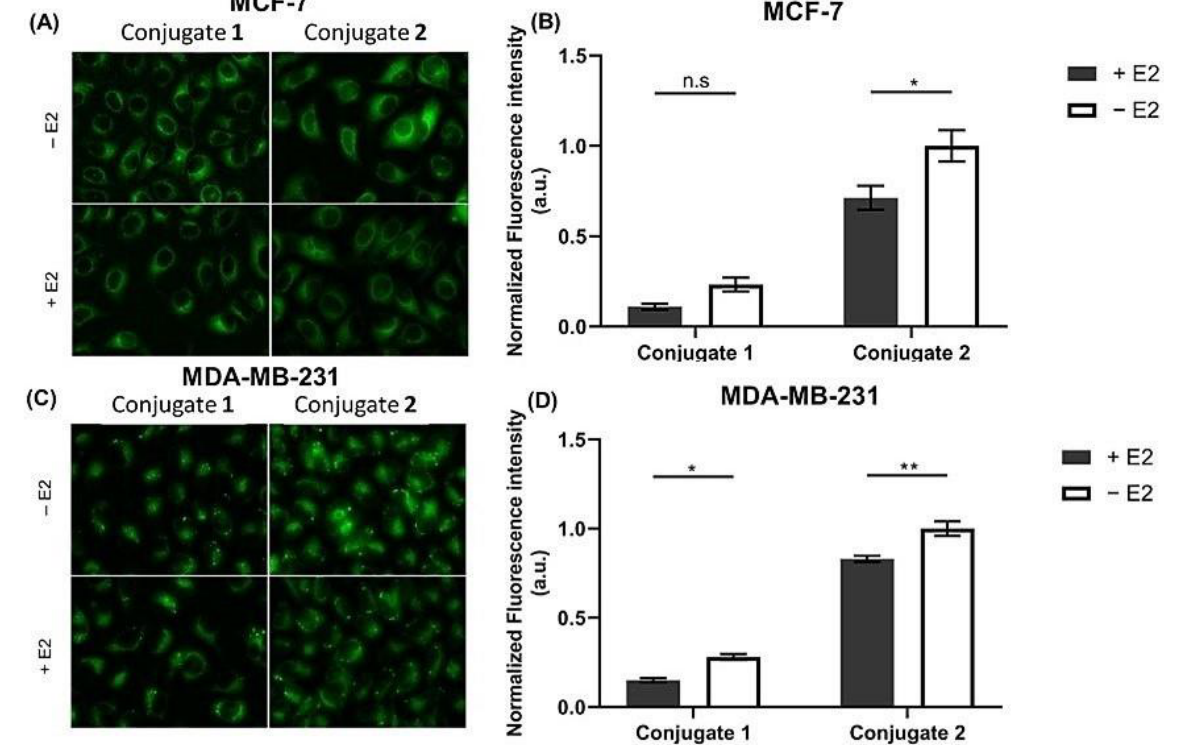
Figure 4. Internalization of estradiol-BODIPY conjugates 1 and 2 in MCF-7 and MDA-MB-231 breast cancer cells with or without E2. MCF-7 and MDA-MB-231 cells were incubated for 1 h with a specific inhibitor (+E2) or without an inhibitor ( − E2). After 6 h of incubation with conjugate 1 or 2 , ( A ) MCF-7 and ( C ) MDA-MB-231 cells and the fluorescence intensity were quantified for each cell line, ( B ) and ( D ), respectively. The fluorescence intensity of the cells was corrected for background fluorescence and normalized with vehicle (DMSO). The statistical significance was evaluated by the two-way ANOVA method (* p ≤ 0.05, ** p ≤ 0.01, n.s—not significant).